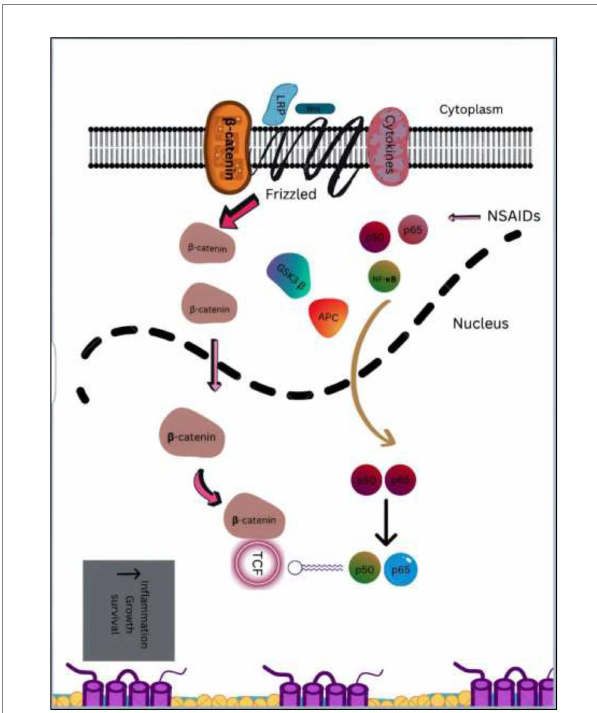
FIGURE 3 An overview of downstream targets in colorectal cancer & NF- κ B and β -catenin/Wnt pathways. Catenin accumulates as a result of APC gene or activating mutations in the β -catenin, which leads to the formation of complex with the TCF/LEF transcription factors. TCF can interact with extra to stimulate the transcription of genes which are proliferative in the colon, including c-Myc and cyclinD1. With the release of p65, that is subsequently translocated to nucleus, inflammatory cytokines activate NF- κ B, which leads to an increase in target gene transcription. NSAIDs in combination with other drugs like naproxen or sulindac targets β -catenin /Wnt and NF- κ B pathways and suppresses downstream